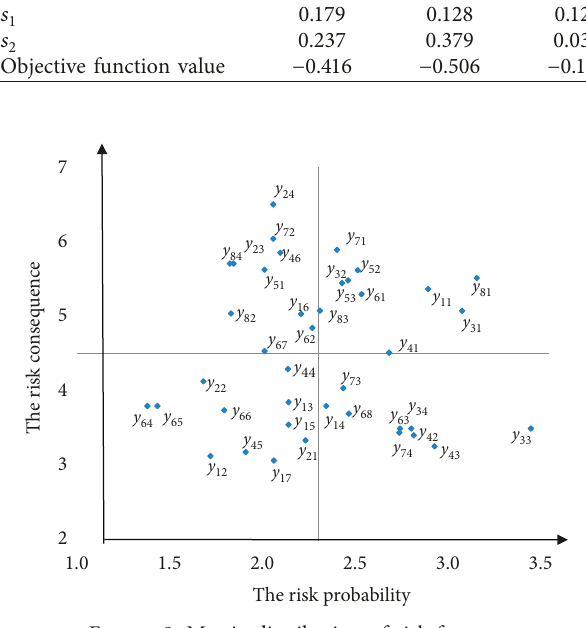
Figure 8: Matrix distribution of risk